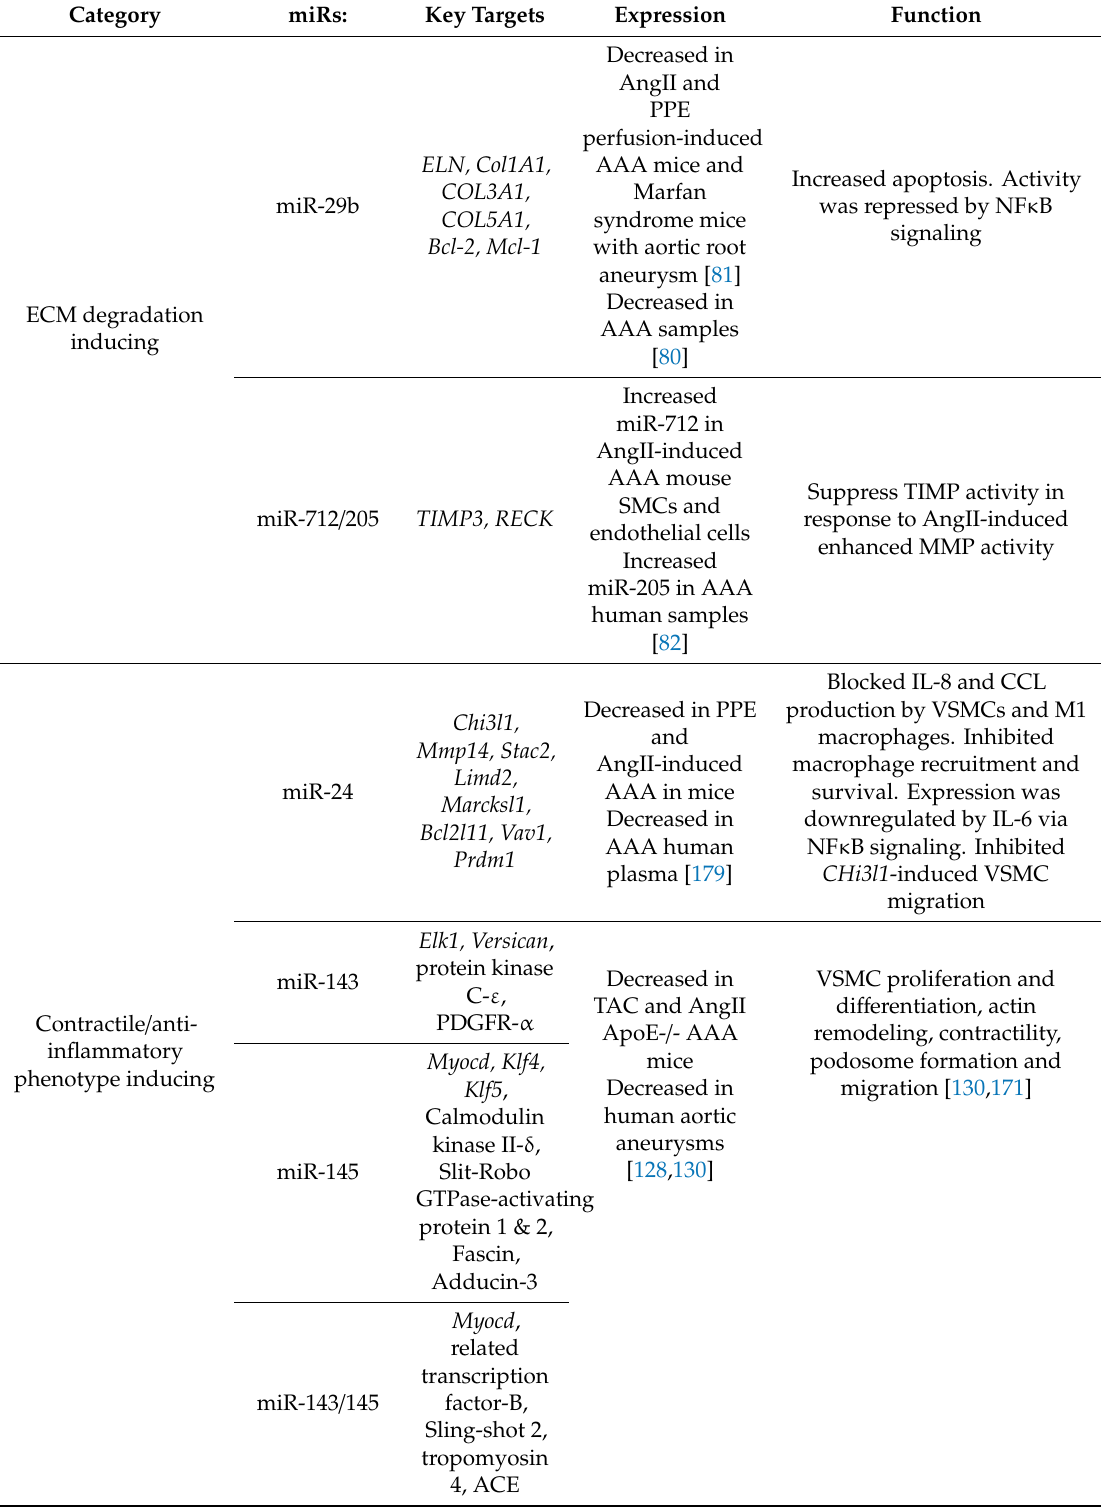
Table 2. miRNAs that are key players in the pathophysiology of AAA organized under three categories: ECM degradation inducing, contractile phenotype inducing, and synthetic phenotype